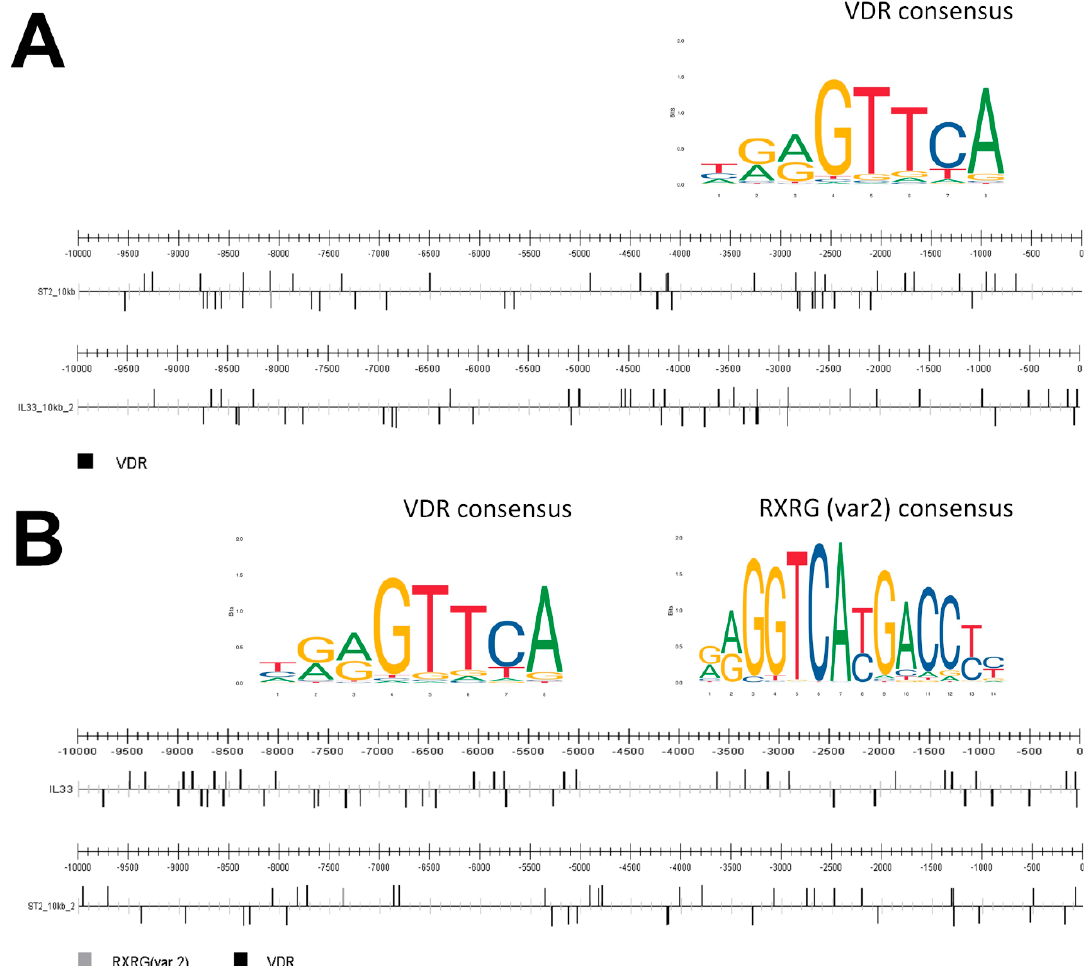
Figure 5. Prediction of VDR binding sites in IL-33 and ST2 genes by the CiiiDER program. ( A ) VDR binding sites (MA0693.2 JASPAR matrix) in the IL-33 sequence 10 kb upstream of ATG, and a second 10kb (10kb-20kb) upstream of ATG. ( B ) VDR (MA0693.2 JASPAR matrix) and RXRGvar2 (MA1556.1 JASPAR matrix) binding sites in the ST2 sequence 10 kb upstream of ATG, and a second 10 kb (10kb-20kb) upstream of ATG.